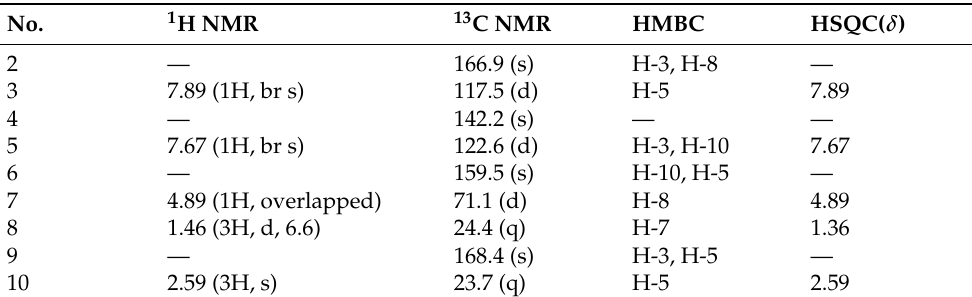
Table 2. The 1 H, 13 C, HMBC, and HSQC NMR data for compound 7 in CD 3 OD.